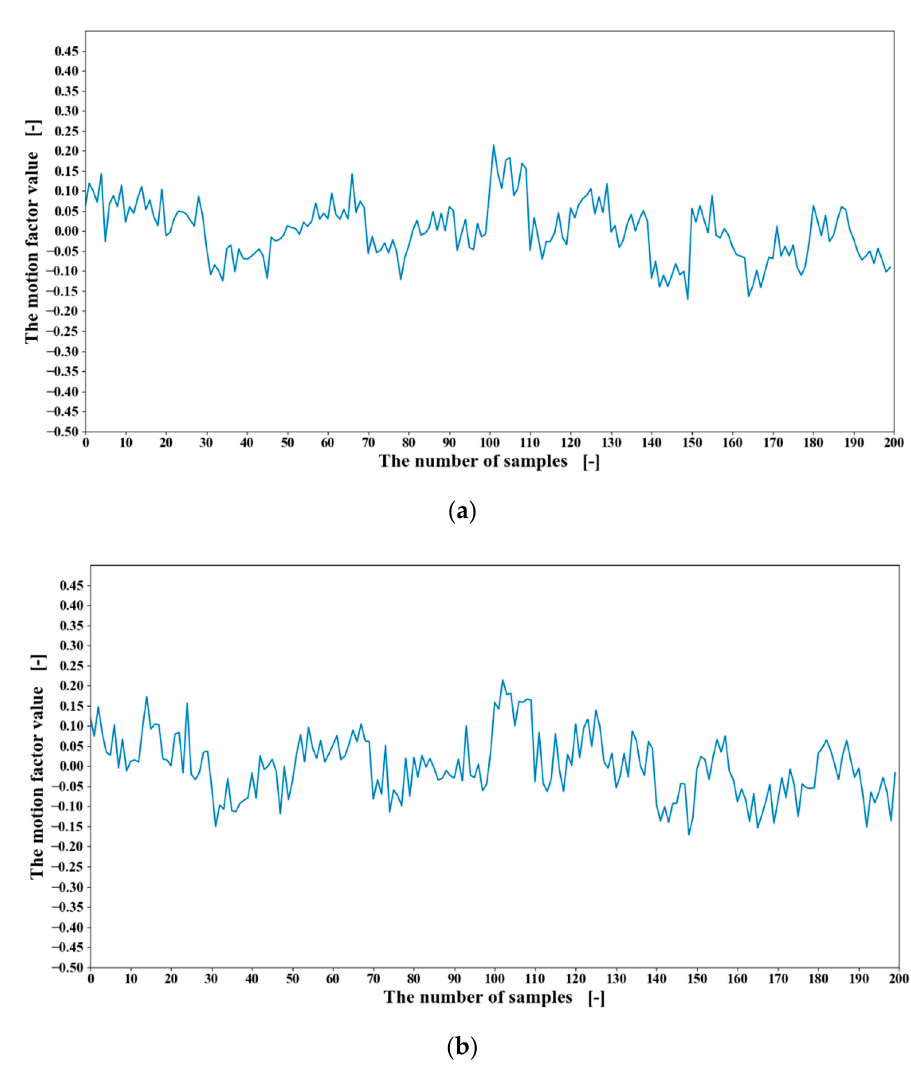
Figure 15. The motion matrix factor values of 20 motions from di ff erent participants; ( a ) participant four; ( b ) participant